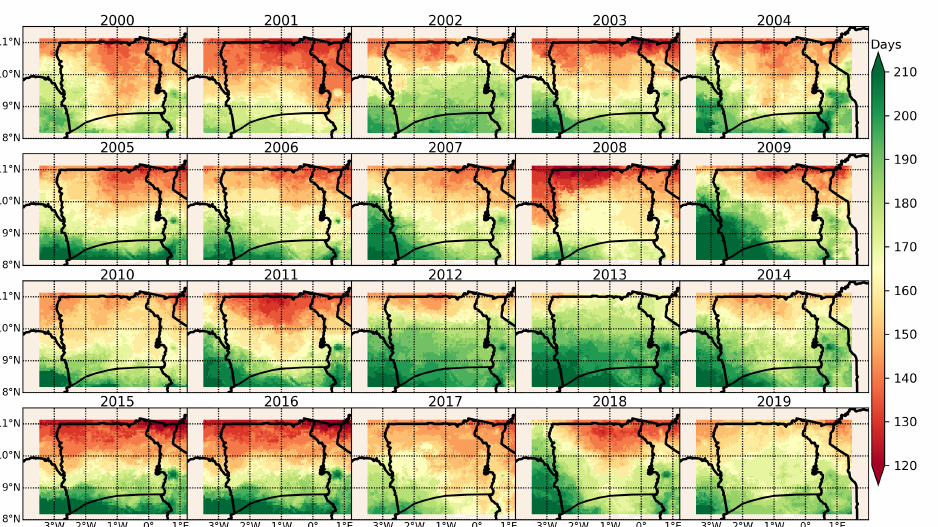
Figure 4. Maps showing the variability of LGP from 2000 to 2019 over Northern Ghana derived from